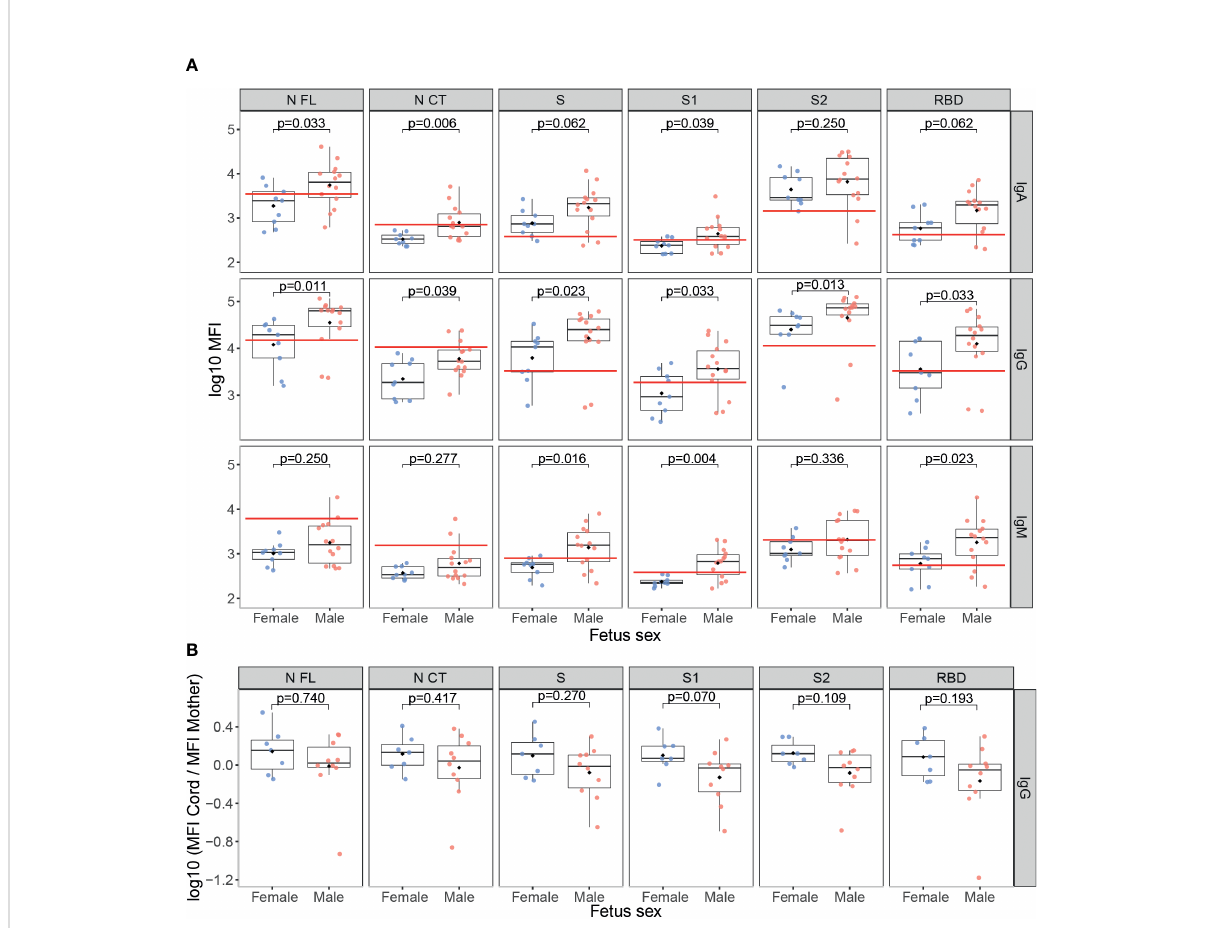
FIGURE 5 Anti-SARS-CoV-2 antibody levels by fetus sex. (A) Comparison of anti-SARS-CoV-2 levels (log 10 median fl uorescence intensity, MFI) in infected mothers between those who had a male fetus (N=14, in red) and those who had a female fetus (N=9, in blue). (B) Comparison of the ratios of IgG levels (log 10 MFI) to SARS-CoV-2 antigens in cord blood vs. mother peripheral blood from seropositive mothers who had a male fetus (N=10, in red) and those that had a female fetus (N=7, in blue). The boxplots represent the median (bold line), the mean (black diamond), the 1 st and 3 rd quartiles (box) and the largest and smallest values within 1.5 times the inter-quartile range (whiskers). Groups were compared by the Wilcoxon-rank-sum-test. The red line indicates the seropositivity cutoff calculated as 10 to the mean plus 3 standard deviations (SD) of log 10 - transformed MFI of 129 pre-pandemic controls. Antigens: nucleocapsid full-length (N FL) and C-terminus (N CT), spike full-length (S), S1 and S2 subunits, and receptor-binding domain